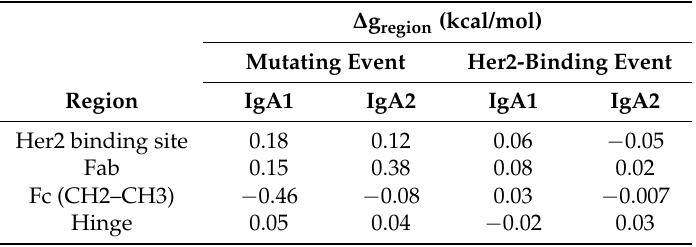
Table 1. Accumulative allosteric effect on various regions (represented by ∆ g region ) using the minimized structures of IgA1 and IgA2, when mutated or when bound to